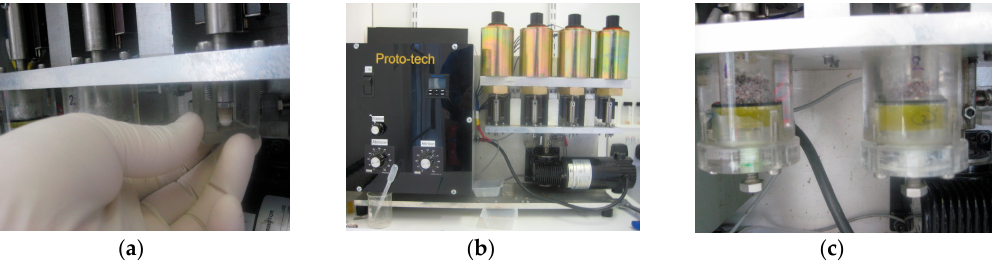
Figure 2. The OHSU oral wear simulator; ( a ) adjustment of the height of antagonist with a custom-made jig and ( b , c ) chambers containing the embedded GIC specimen, slurry and antagonist.